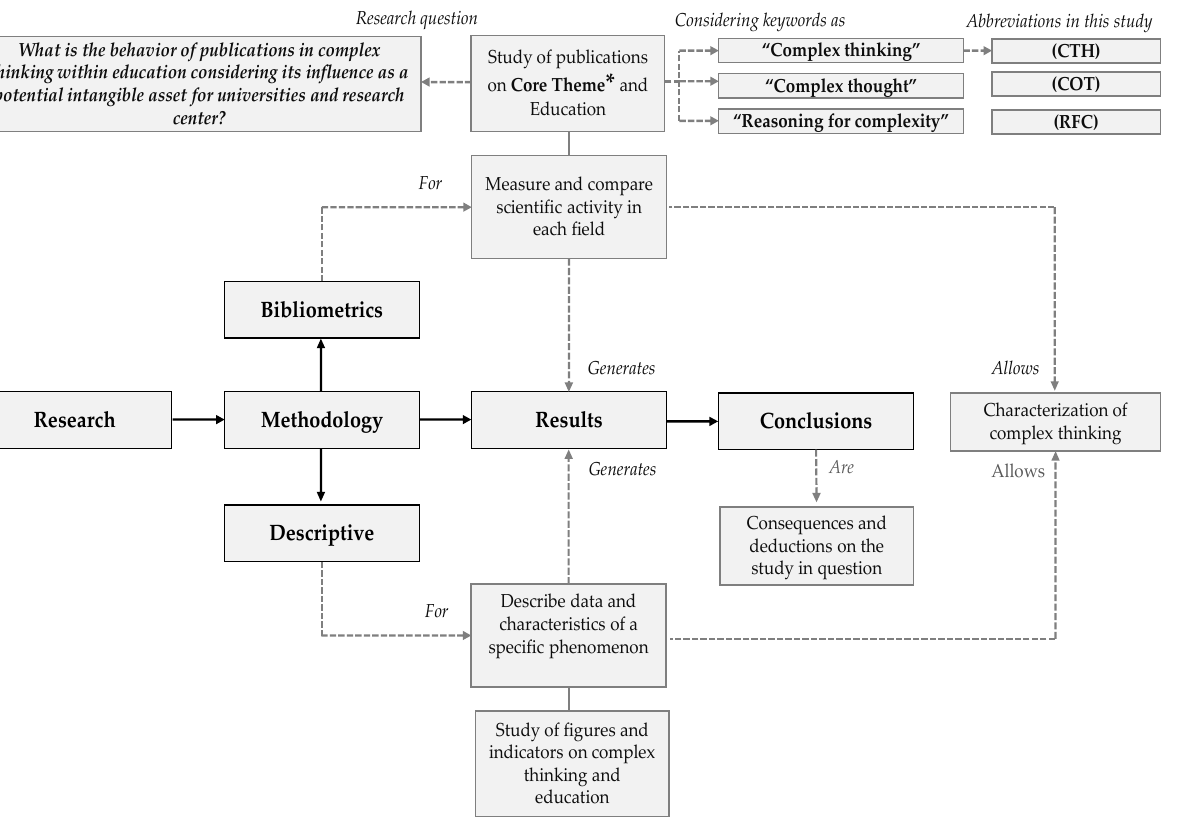
Figure 2. Processing of information from the methodological approach. Source: own elaboration based on Cortés Vargas (2007) and Lahitte et al. (2010).